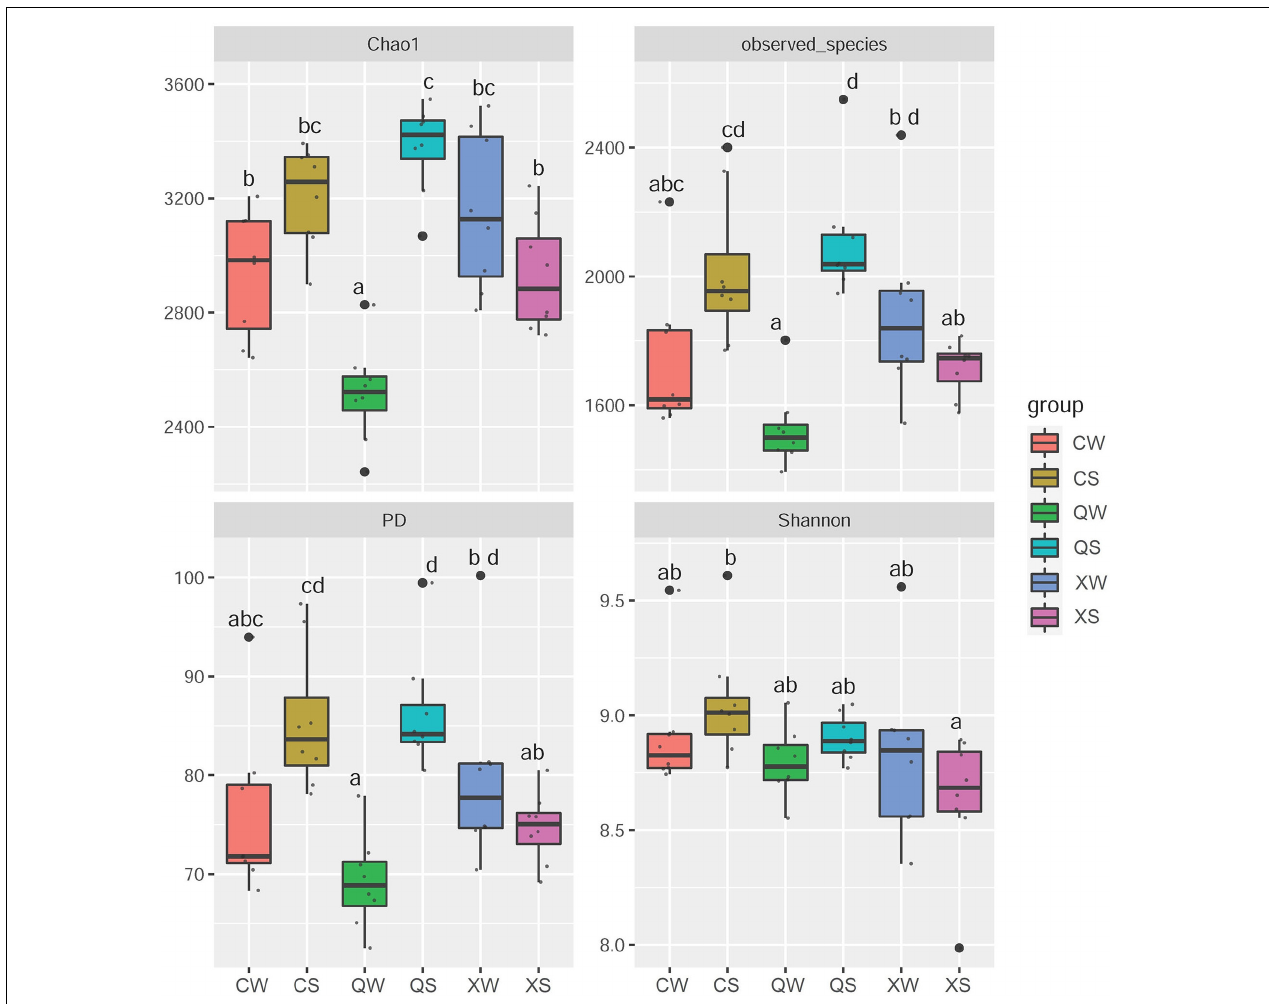
FIGURE 3 | α -diversity metrics (Observed_species, Chao1, Shannon, and PD indices) in all groups of Nibea albiflora male, female, and all-female fish, during an investigation of the composition of the intestinal microbiota. PD: Phylogenetic diversity. X, C, and Q represented male, female, and all-female fish, respectively. Two seasons: summer (S) and winter (W). After running an ANOVA, post hoc Duncan tests were conducted to analyze the differences in the α -diversity metrics among the female, male, and all-female fish. Data with different letters at the column indicated significant differences.